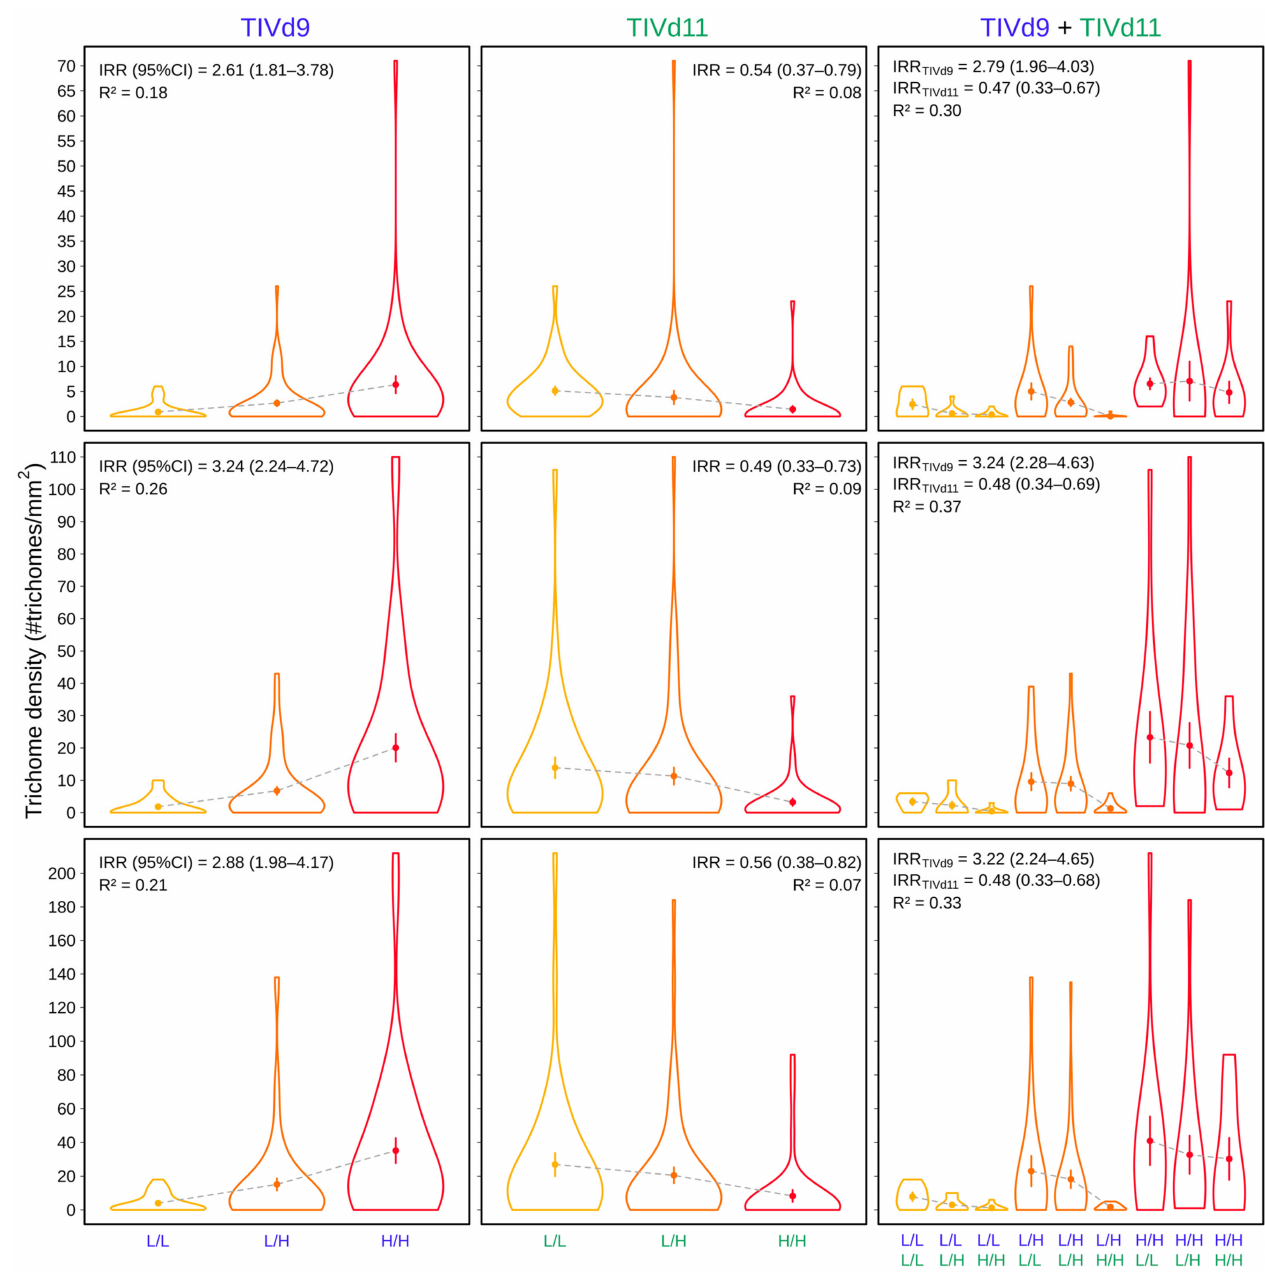
Figure 4. Effect of QTLs TIVd9, TIVd11 and the additive model on trichome density along the three phenotyped weeks (6th, 7th, 8th weeks after transplanting. Incidence rate ratio (IRR) and 95% confidence intervals (values between brackets) and Nagelkerke R 2 of the negative binomial logistic regression are shown for each combination. Violin plots for the two homozygotes (L/L and H/H) and the heterozygote (L/H) are represented. L refers to an allele of the low trichome density parental (LA2278) and H to an allele of the high trichome density parental (BGV016047). Mean trichome density and standard error for each genotype is shown inside each violin